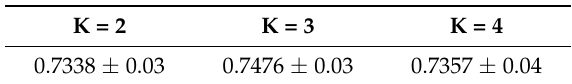
Table 3. Performance comparison among different parameter settings (k = 2, 3, 4) in the framework of 5-fold cross validation.